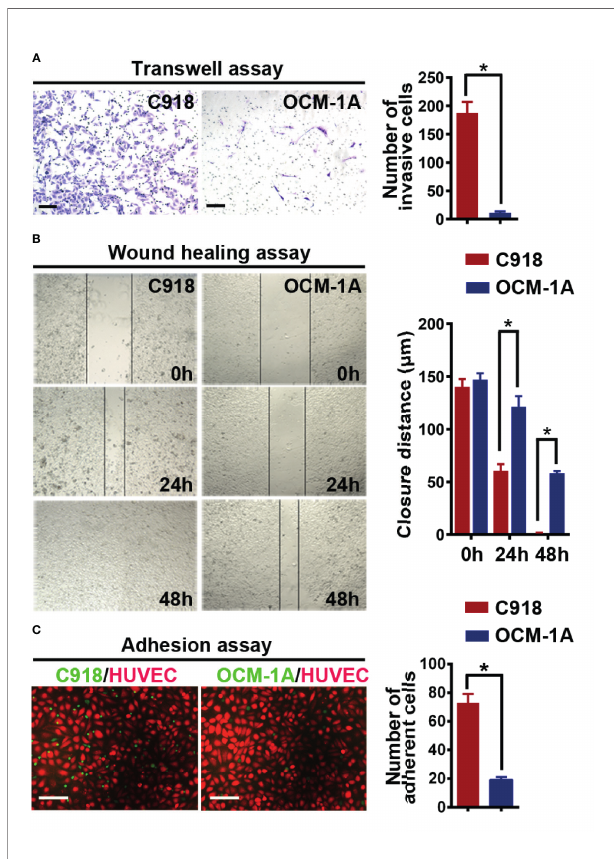
FIGURE 1 | C918 cells show higher invasion/migration ability and stronger interaction with the endothelium. (A) Transwell invasion assay reveals higher invasive ability of C918 cells when compared with OCM-1A cells. The average numbers of invasive C918 or OCM-1A cells per three non-overlapping fi elds were counted (minimum of three trials each) ( t test; P < 0.0001). (B) Wound healing assay reveals faster migration of C918 cells when compared with OCM-1A cells. The closure rate of cells in the wound healing assay was determined for C918 and OCM-1A cell lines (minimum of three trials each) ( t test; 0 h, P = 0.22, 24 h, P = 0.0054; 48 h, P = 0.0004). (C) Numbers of adherent melanoma cells (green) on HUVECs (red) are shown. Melanoma- GFP cells remaining on the monolayer of HUVEC-mCherry cells were counted (10 fi elds from three independent experiments) ( P < 0.0001). Scale bar 100 m m. * P